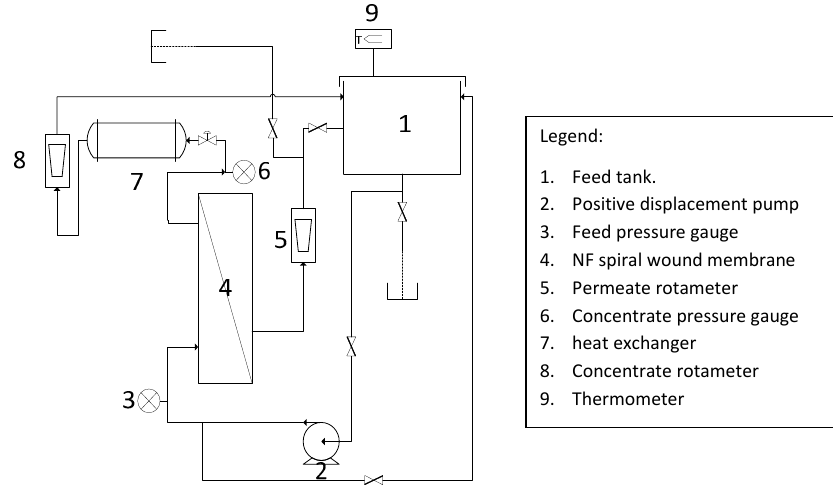
Figure 1. Schematic diagram of nanofiltration (NF) spiral wound system.